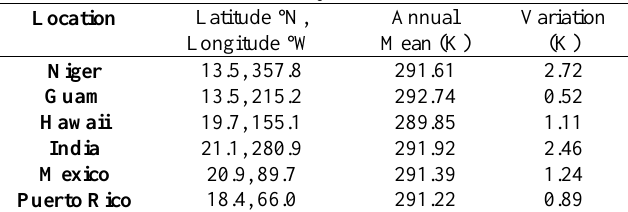
Table 5. Several selected radiosonde stations utilized by Ross and Rosenfeld, (1997). From 53 radiosonde stations, only 5 stations are located near low-latitude. They did not include any radiosonde station located close to equatorial region such